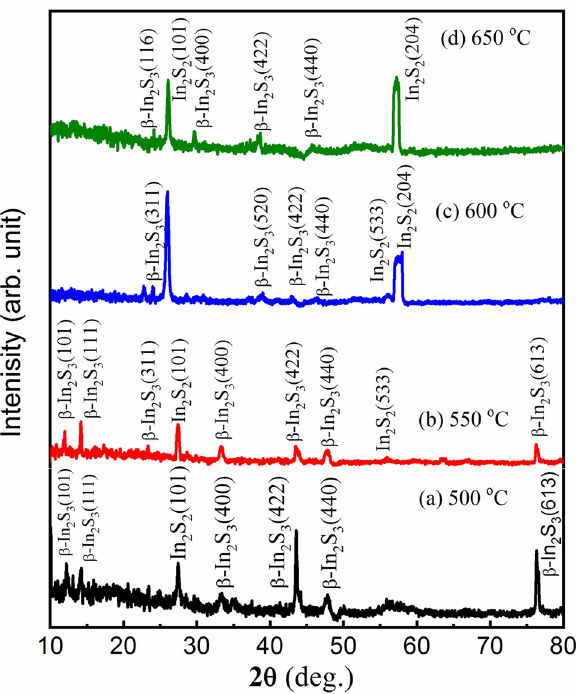
Figure 2. ( a – d ). The XRD patterns of the grown thin film of In 2 S 3 at pressure 100 Torr., and different temperatures ( a ) 500 °C, ( b ) 550 °C, ( c ) 600 °C, and ( d ) 650